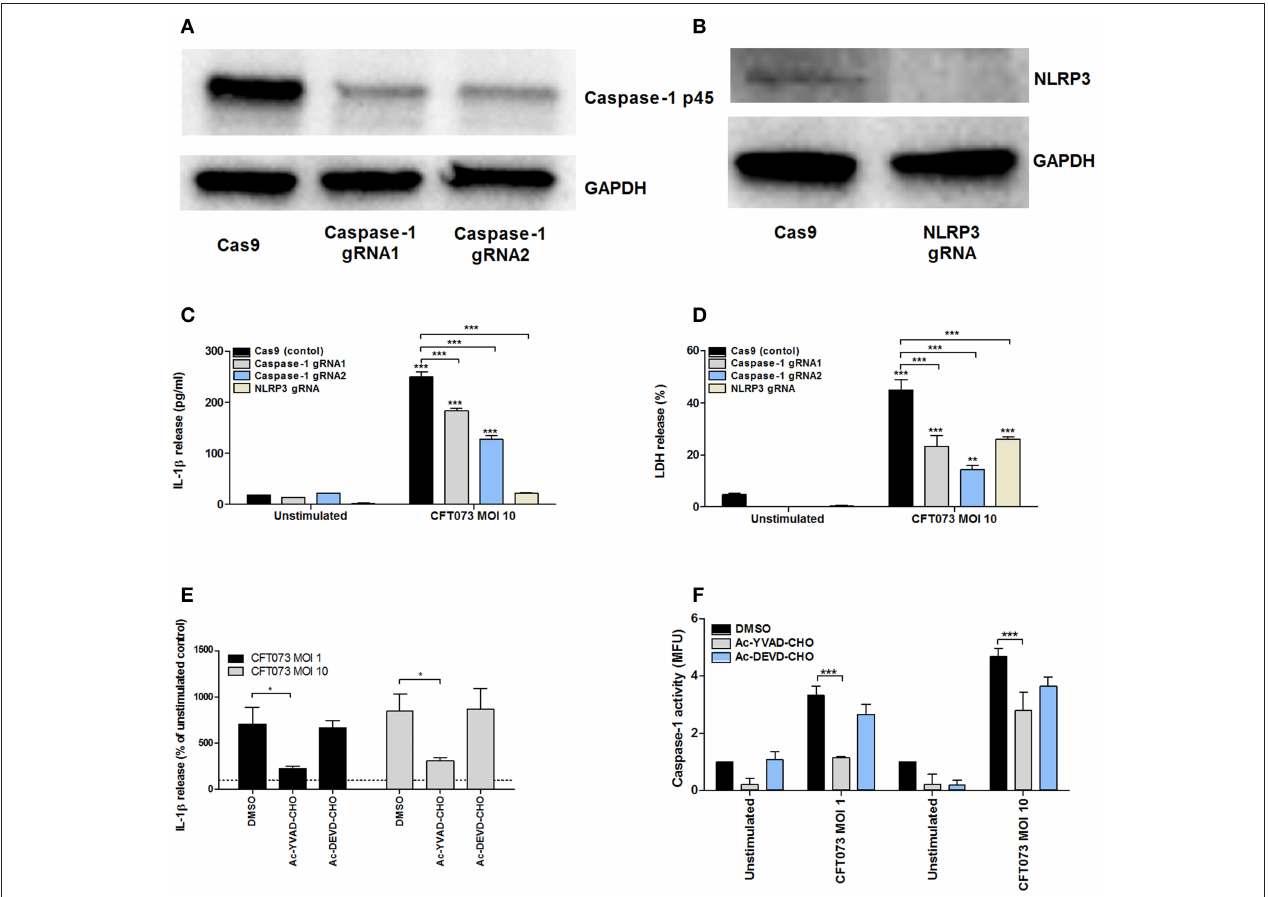
FIGURE 5 | Analysis of IL-1 β release, caspase-1 activity and LDH release in caspase-1 or NLRP3 deficient 5637 cells. Caspase-1 (A) and NLRP3 (B) knockdowns were created by CRISPR/Cas9 and evaluated by Western blot. GAPDH was used as a loading control. Cas9 (control cells), -caspase-1, or NLRP3-deficient bladder epithelial 5637 cells were infected with CFT073 for 6h at MOI 10. IL-1 β (C) and LDH release (D) were measured. 5637 cells were pre-incubated with DMSO, the caspase 1/4 inhibitor AC-YVAD-CHO (10 µ M) or the caspase 3 inhibitor AC-DEVD-CHO (10 µ M) for 1h prior to infection with CFT073 at MOI 1 and 10 for 6h followed by analysis of IL-1 β release (E) and caspase-1 activity (F) . Caspase-1 results are presented as fold increase of mean fluorescence units (MFU) compared to unstimulated control cells. LDH release is presented as % of total LDH. IL-1 β release is presented as % of unstimulated control and the dotted line represents the unstimulated control (E) . Data are presented as mean ± SEM ( n = 3 independent experiments). Asterisks denote statistical significance compared to respective unstimulated control (* p < 0.05, ** p < 0.01, *** p < 0.001).